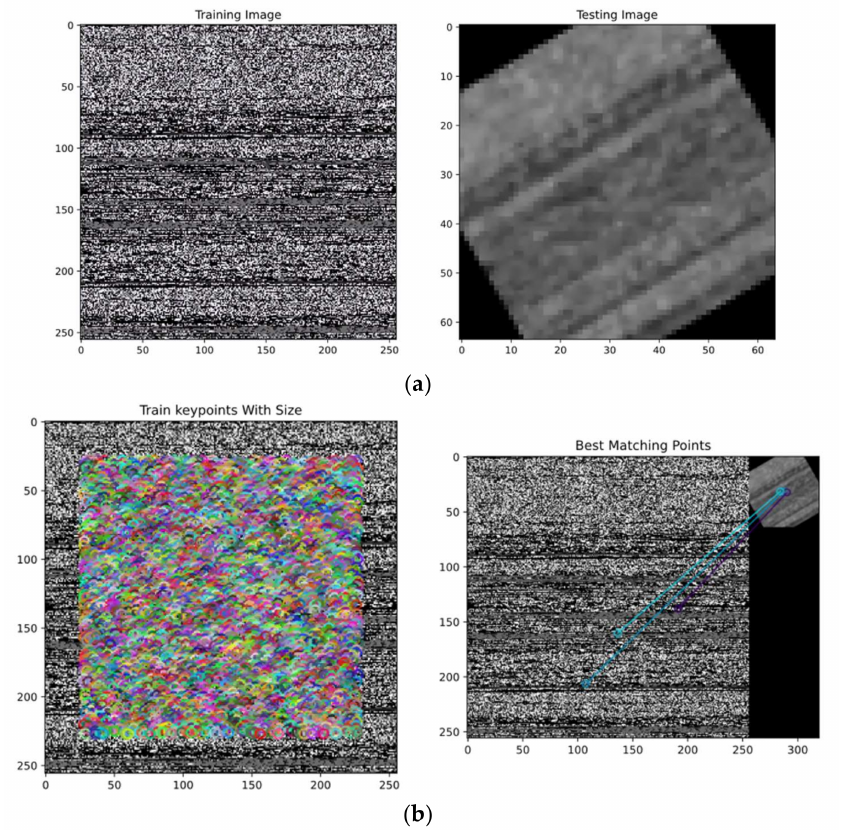
Figure 6. Tracking of features between train and test malware images: ( a ) train and test images (scale and rotation invariant); ( b ) train key points with the best matching